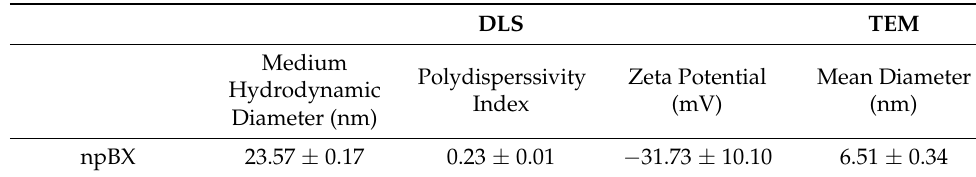
Table 1. Physical characterization of npBX.